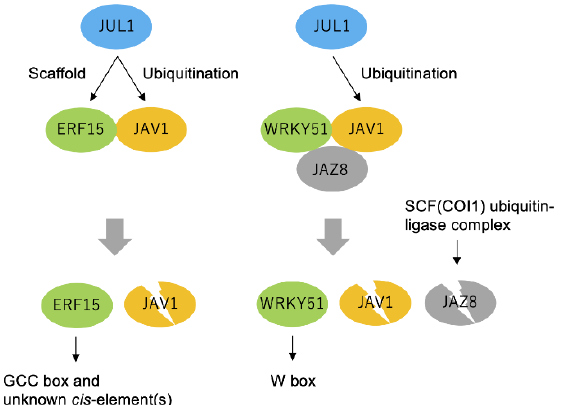
Figure 6. A possible model of the two ways of JUL1-catalyzed JAV1 ubiquitination when ERF15 or WRKY is captured by JAV1 in Arabidopsis thaliana . In brief, in the steady state of the plant, the JAV1/ERF15 complex has different constituent molecules from the JAV1/WRKY51 complex which harbors JAZ8. In response to herbivory, JUL1 starts ubiquitination of JAV1 with a scaffold on ERF15, resulting in degradation of JAV1 via the ubiquitin-26S proteasome system. On the other hand, the JAV1/WRKY51/JAZ8 complex is decomposed with degradation of JAV1 and JAZ8 via JUL1 and SCF(COI1) ubiquitin-ligase complex, respectively. The consequent releases of ERF15 and WRKY51 act at the respective specific cis -elements, leading to gene regulation.